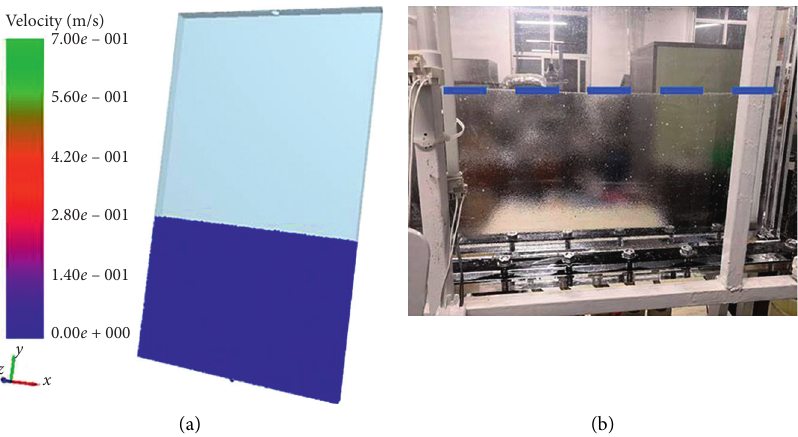
Figure 4: Image illustration of the static steady regime: (a) numerical observation; (b) experimental observation.